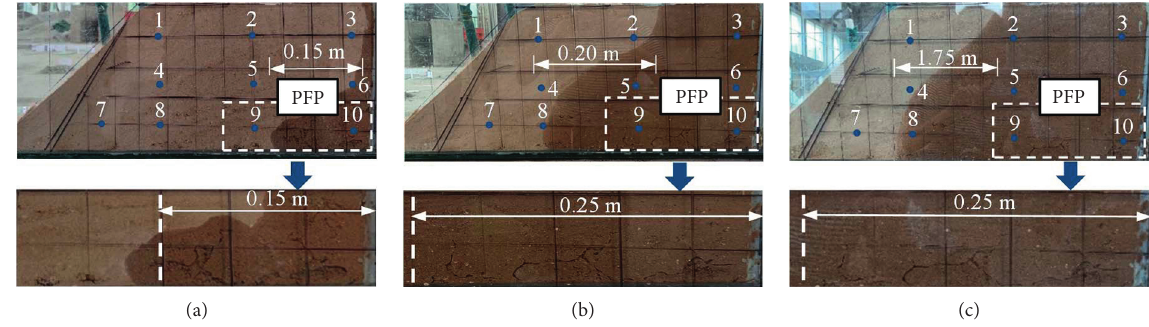
Figure 3: Growth and distribution of the preferential flow path. (a) At T � 2h. (b) At T � 20 h. (c) At T � 30